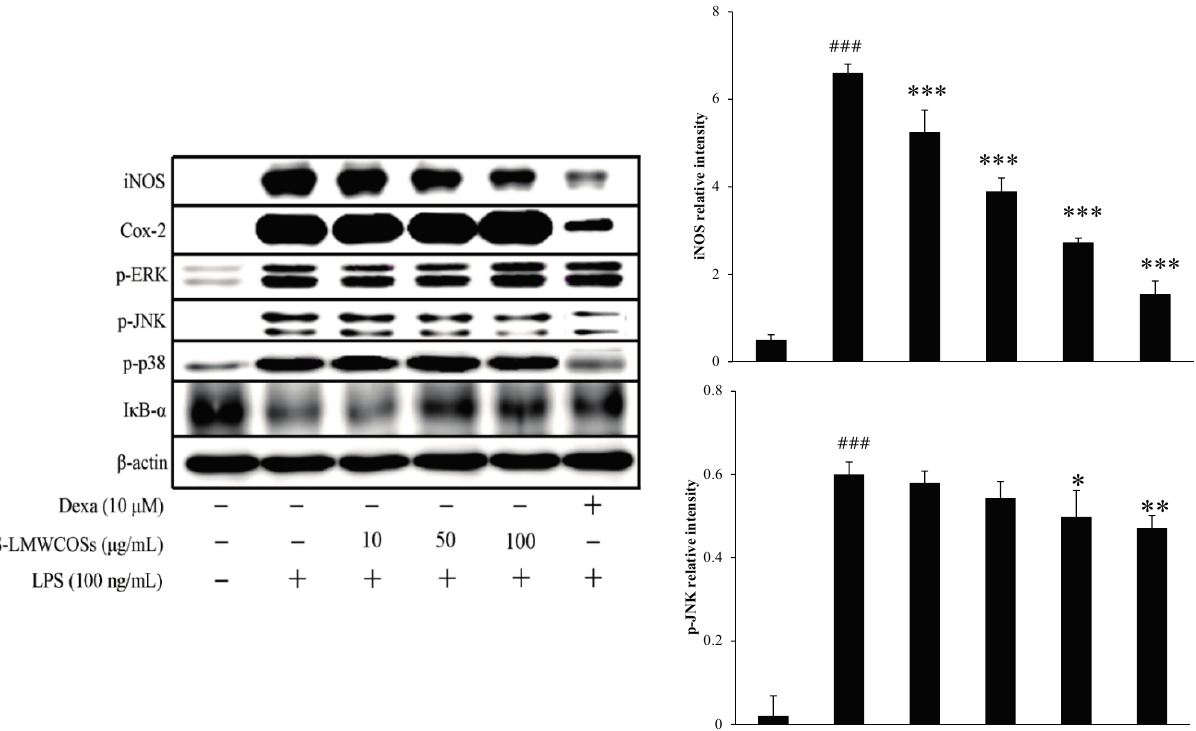
Figure 6. Effects of S-LMWCOSs on the regulation of various protein expression levels in LPS-stimulated RAW264.7 cells. iNOS, Cox-2, p-ERK, p-JNK, p-p38, I κ B- α and actin expression levels were determined by western blotting. Dexamethasone (Dexa) used as positive control. The results shown are from one representative experiment repeated twice, with similar results. ### p < 0.001 versus control, * p < 0.05, ** p < 0.01, *** p < 0.001 versus LPS alone